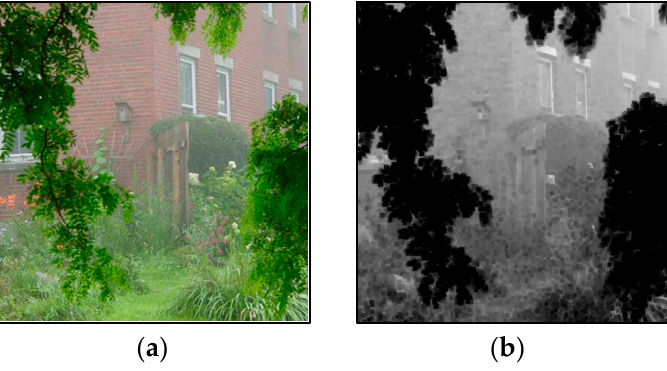
Figure 5. Initial value of the transmission map. ( a ) Input hazy image; and ( b ) the initial value of the transmission map.